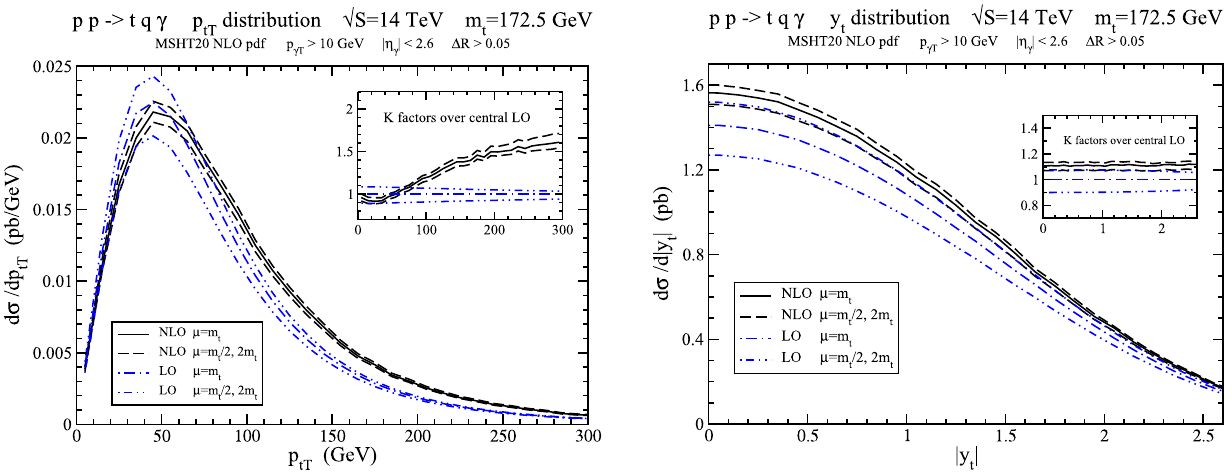
Fig. 5 The LO and NLO top-quark p T (left) and rapidity (right) distributions in tq γ production at 14 TeV LHC